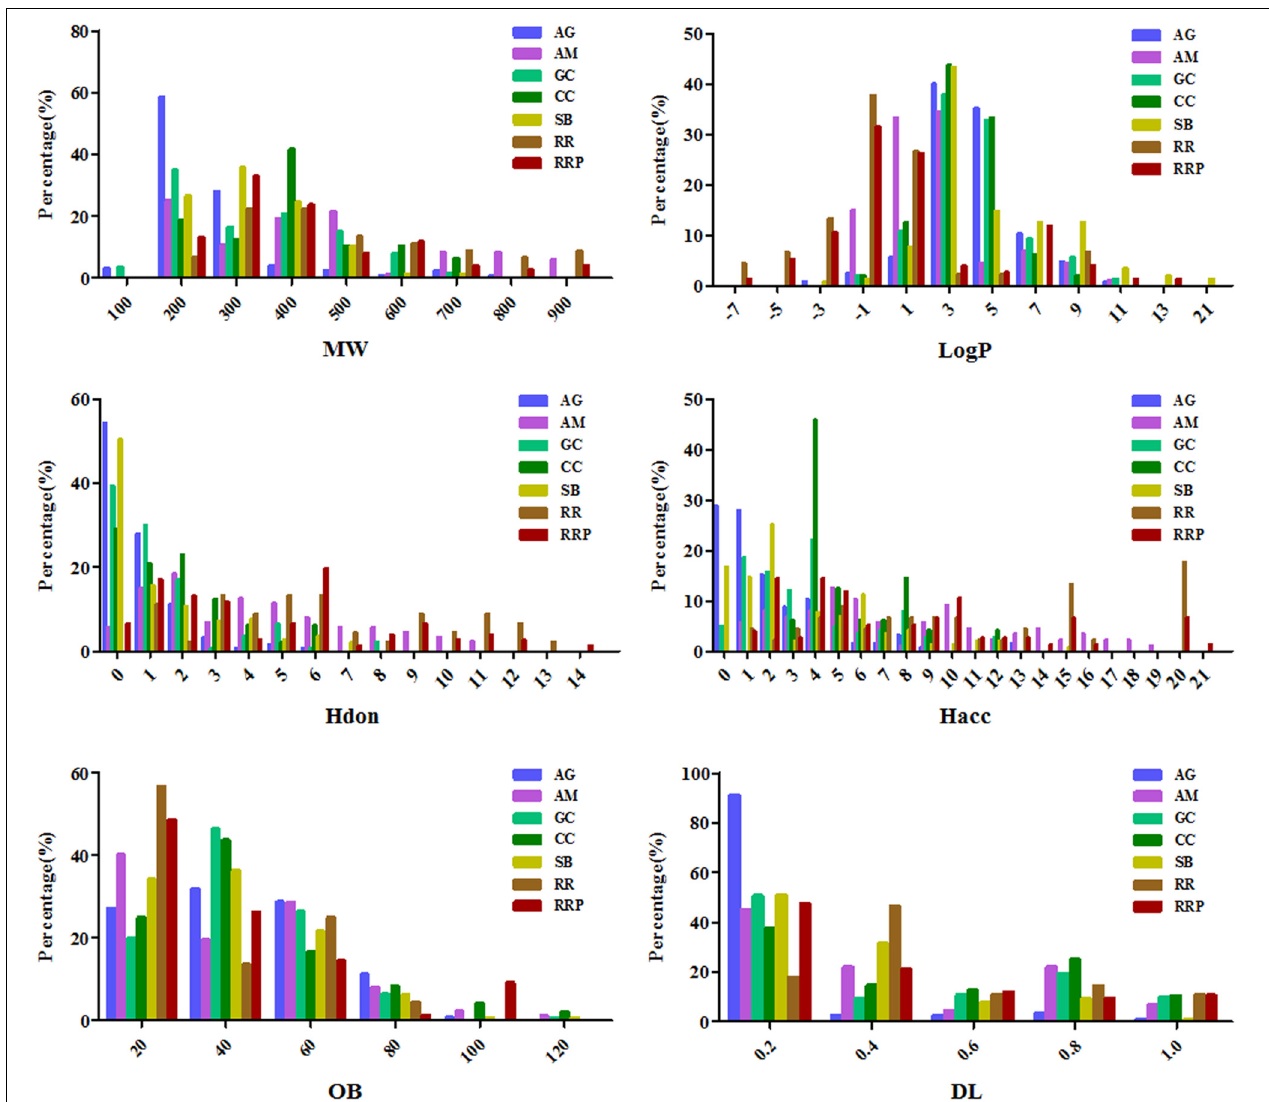
FIGURE 1 | The profile distributions of all ingredients in Dangguiliuhuang decoction (DGLHD). There are seven herbs in DGLHD including angelica (AG), astragalus membranaceus (AM), golden cypress (GC), coptis chinensis (CC), scutellaria baicalensis (SB), radix rehmanniae (RR), radix rehmanniae praeparata (RRP). The molecular properties are mainly composed of molecular weight (MW), oral bioavailability (OB), drug-likeness (DL), the number of donor atoms for H-bonds (nHDon), the number of acceptor atoms for H-bonds (nHAcc) and Moriguchi octanol–water partition coefficient (logP)